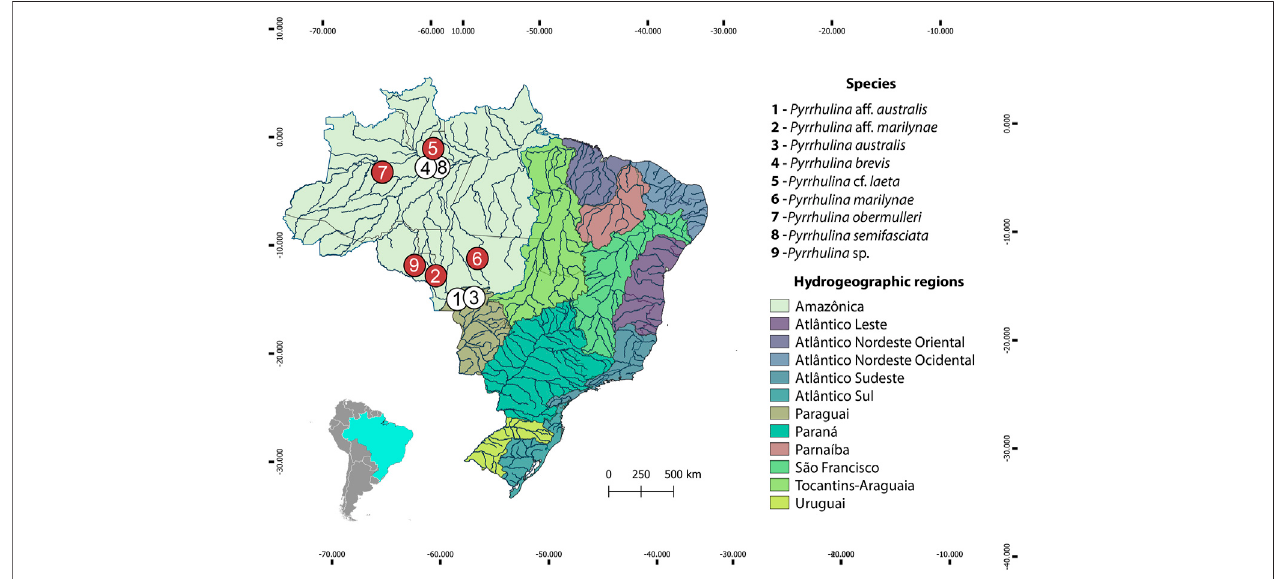
FIGURE 1 | Brazilian collection sites of the Pyrrhulina species cytogenetically investigated in the present study (red circles) and the ones previously cytogenetically analyzed (white circles: data from (de Moraes et al., 2017; de Moraes et al., 2019).